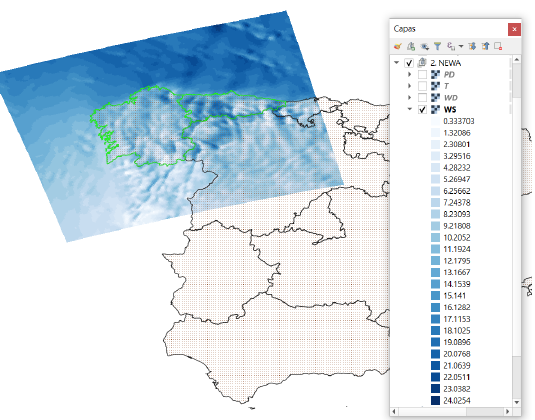
Figure 13. NEWA: Wind speed (m/s) at 75 m. Own